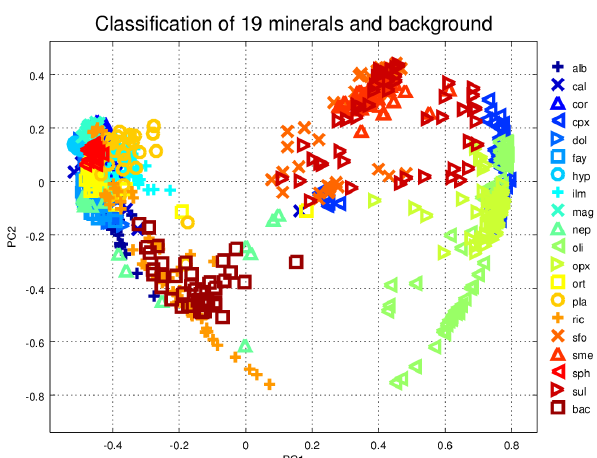
Figure 10. Classification of 19 minerals and background of a sub- strate. The PC components show only the most pronounced fea- tures. The classification matrix is shown in Table 4. Each sample is represented by a marker. The colours and markers represent indi- vidual classes. The elements are the same as in Table 4. More quan- titative details are seen only when rotating a 3-D image of suitably chosen principal